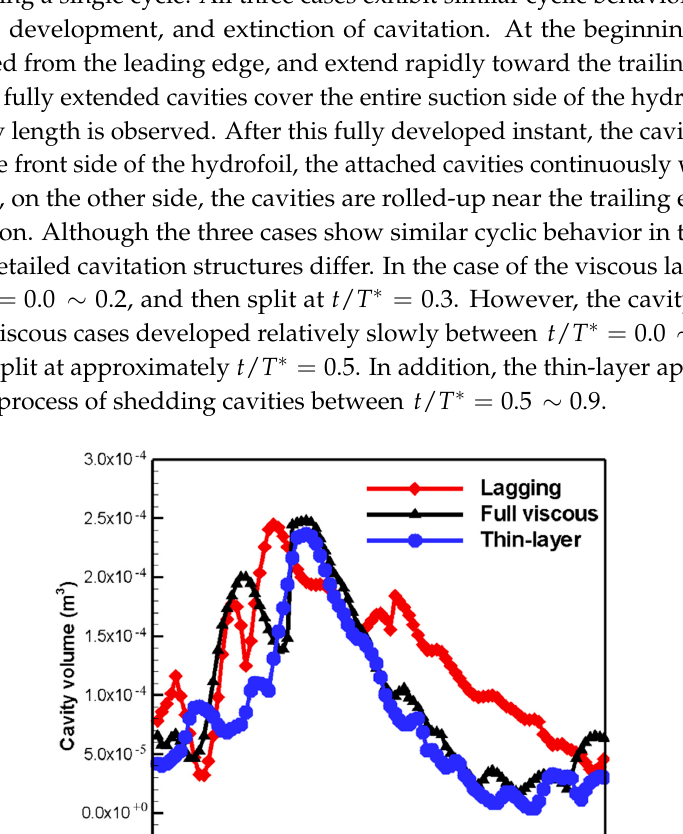
Figure 5. Time-variations of predicted cavity volume of three different viscous flux vector treatment methods.